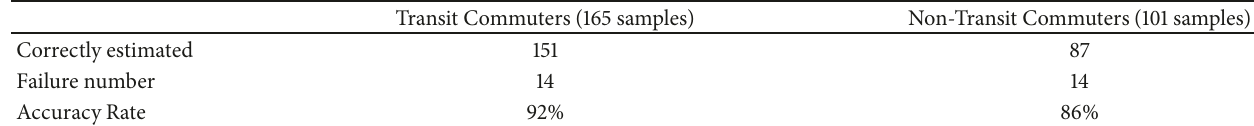
Table 3: Test Results of the trained